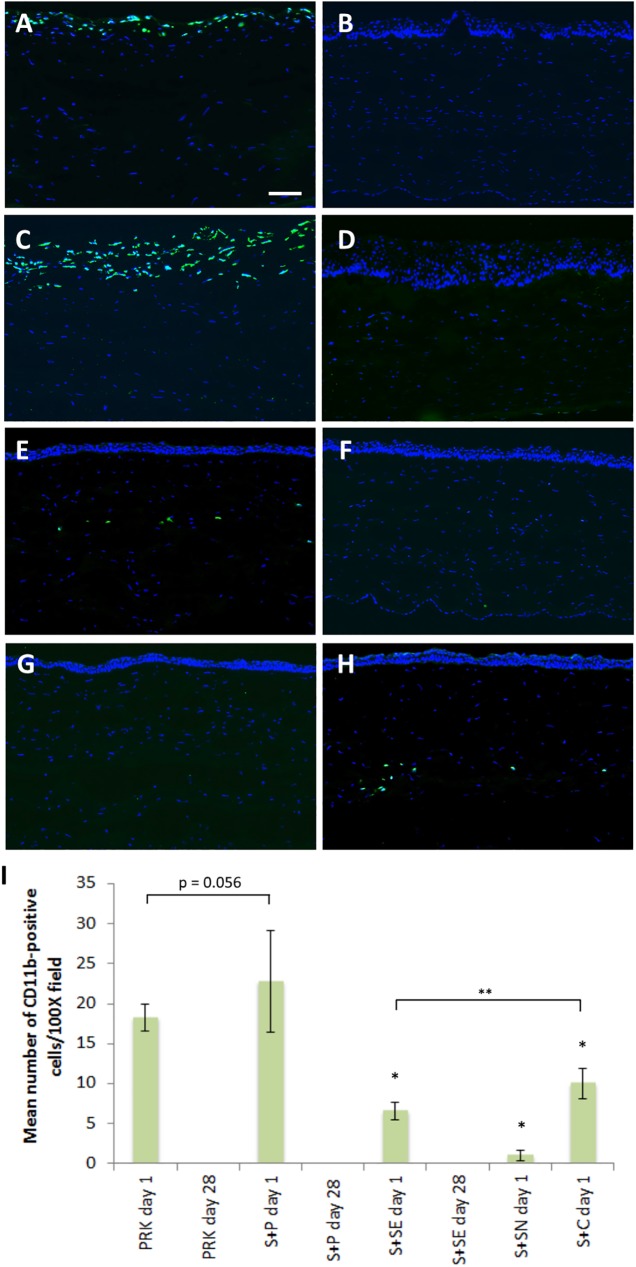
Expression of CD11b in the central cornea after SMILE retreatment.(A) Abundant of inflammatory cells was present 2–3 cells deep at the superficial layer of the exposed stroma 1 day after PRK alone (PRK day 1 group). (B) After 28 days, no inflammatory cells was seen in the stroma (PRK day 28 group). (C) CD11b-positive cells were abundantly present on day 1 in cornea treated with S+P only (S+P day 1 group). (D) Similar to PRK day 28, the inflammation was resolved on day 28 (S+P day 28 group). (E) Relatively less inflammatory cells were seen along the cap interface of the secondary SMILE after extraction of lenticule (S+SE day 1 group). (F) No CD11b staining was detected in S+SE day 28 group. (G) No inflammation occurred when the secondary SMILE lenticule was left not extracted (S+SN day 1 group). (H) Inflammatory cells were observed along the flap interface after flap creation utilizing VisuMax Circle software and subsequent stromal excimer ablation (S+C day 1 group). (I) Quantification of CD11b-positive cells in the central corneal stroma after different SMILE retreatment methods. Data were analyzed using one way ANOVA and a post hoc Tukey comparison procedure. *p<0.001 relative to S+P day 1. **p<0.05.Scale bar = 50 μm.